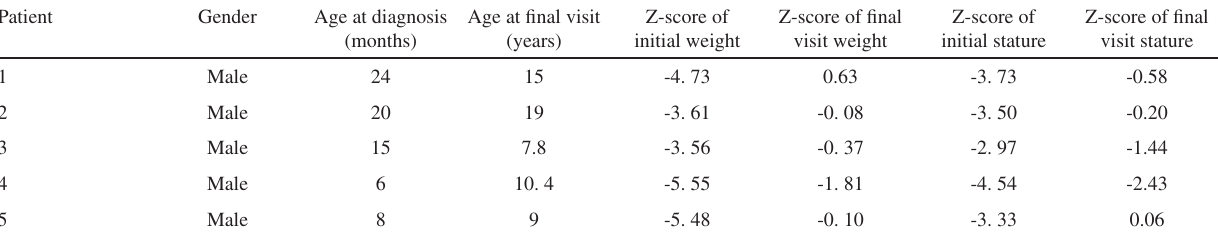
Table 1 - Summarized data from the five NDI patients Patient